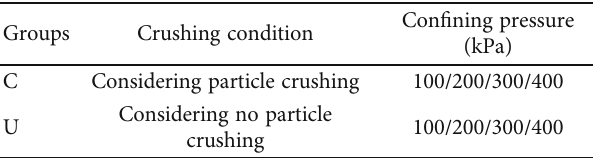
Table 3: Numerical test scheme.